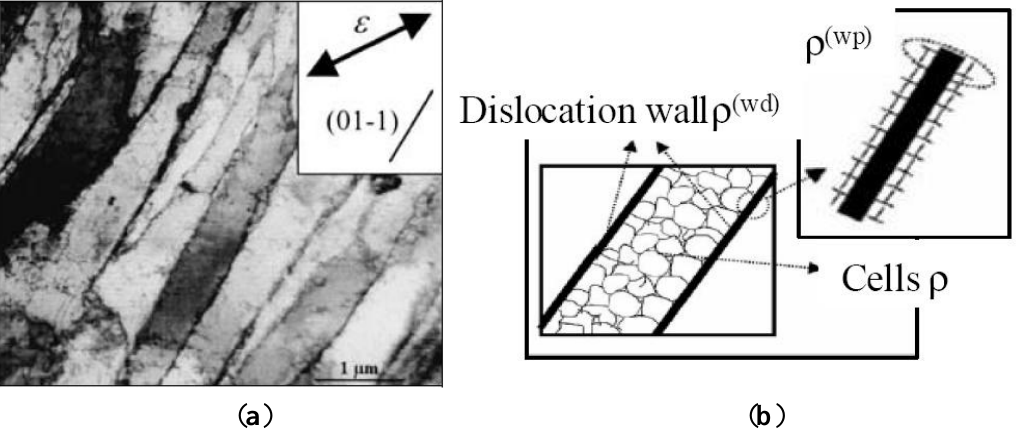
Figure 1. ( a ) Longitudinal plane view transmission electron microscopy (TEM) micrograph of a grain of an IF-steel (interstitial-free steel) specimen after 20% uniaxial tension in RD (after Peeters et al. [11]). ( b ) Schematic representation of the heterogeneous dislocation